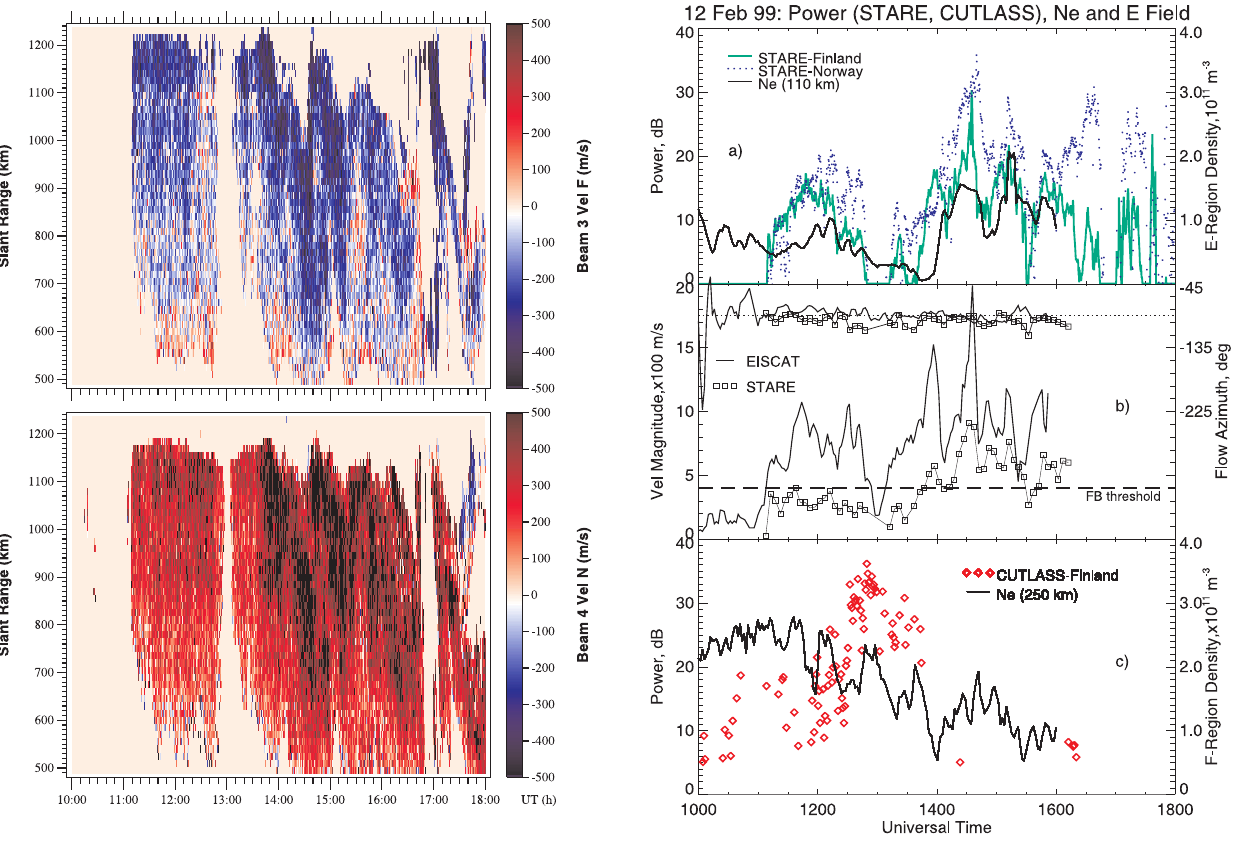
Fig. 3. Plots of STARE VHF echo Doppler velocity versus time in beam 3 for the Finland radar and beam 4 for the Norway radar for the event of 12 February 1999, 10:00–18:00UT.